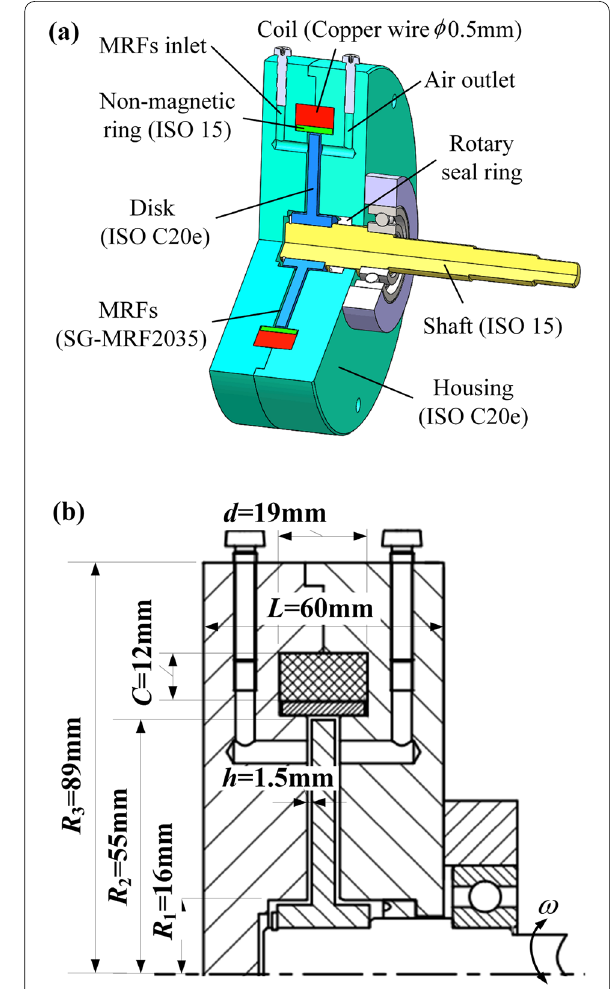
Figure 3 Structural diagram of the disk-type MR damper: ( a ) Three-dimensional model, ( b ) two-dimensional sectional